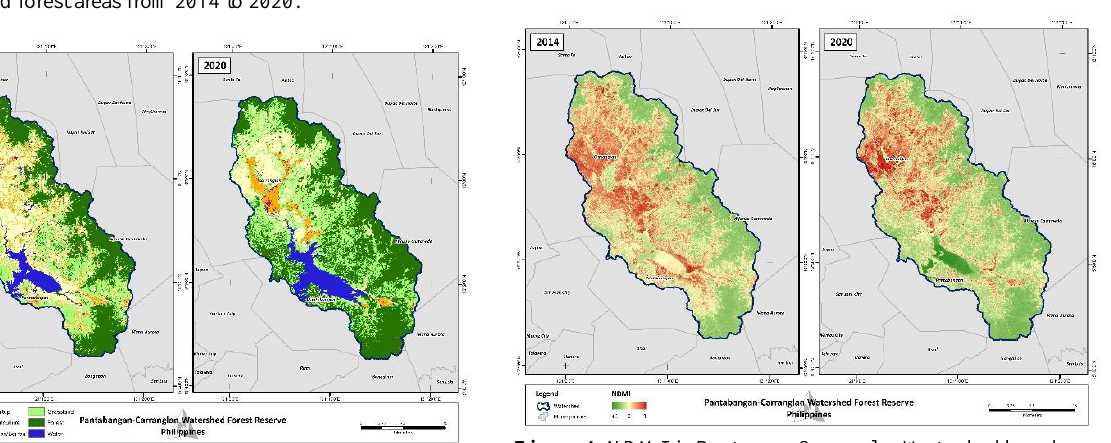
Figure 3. Classified Land Use/Land Cover of Pantabangan- Carranglan Watershed for 2014 and 2020.